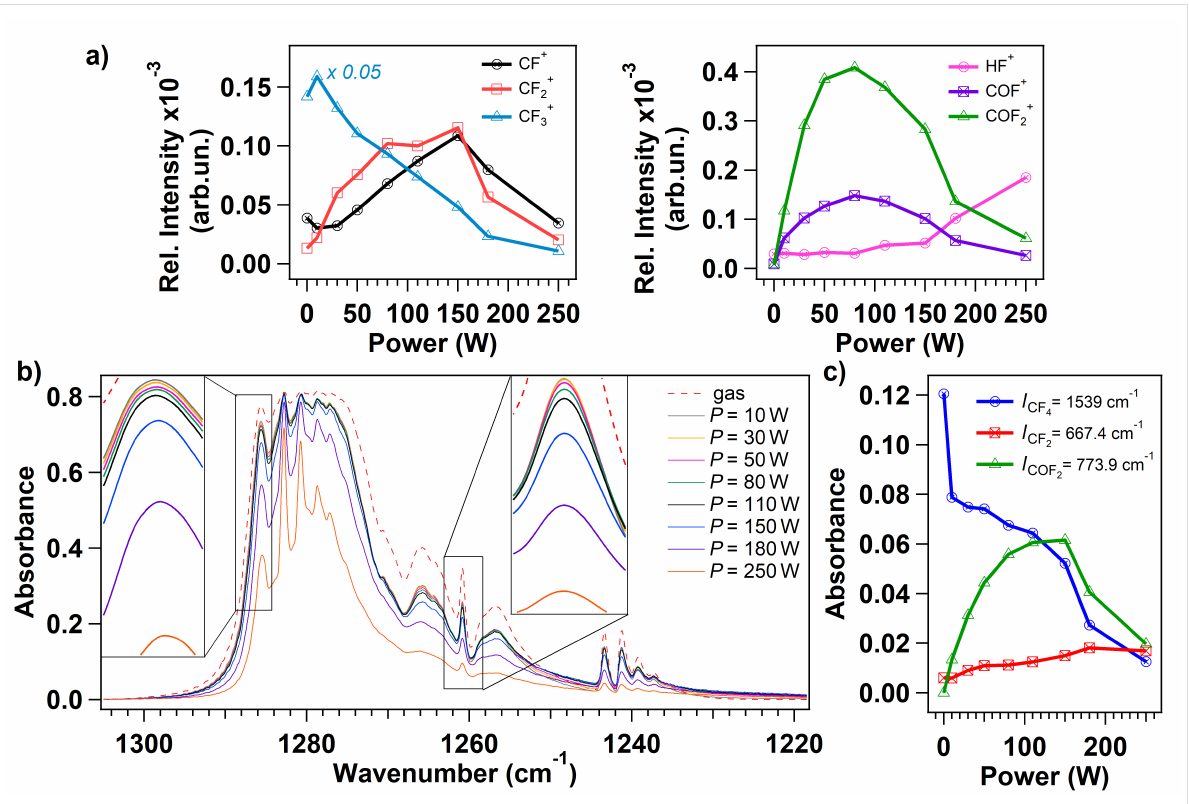
Figure 2: a) Evolution of the normalized ion signals, extracted from the mass spectra at different plasma power (the working pressure is set to 10 mTorr). The masses under study are relative to the following ionized species: CF ( m / z = 31 amu), CF 2 ( m / z = 50 amu), CF 3 ( m / z = 69 amu), and HF ( m / z = 20 amu), COF ( m / z = 47 amu), COF 2 ( m / z = 66 amu). b) FTIR spectra acquired during pure CF 4 gas phase (dotted line) and during CF 4 plasma ignited at different power (from 10 to 250 W). The two frames in the figure detail the peaks located at 1286 and 1261 cm − 1 for better visualiza- tion of the intensity variation. c) Intensities of the FTIR peaks related to CF 4 (at 1539 cm − 1 ), CF 2 (at 667.4 cm − 1 ) and COF 2 (at 773.9 cm − 1 ) are shown for different power used to initiate the discharge.